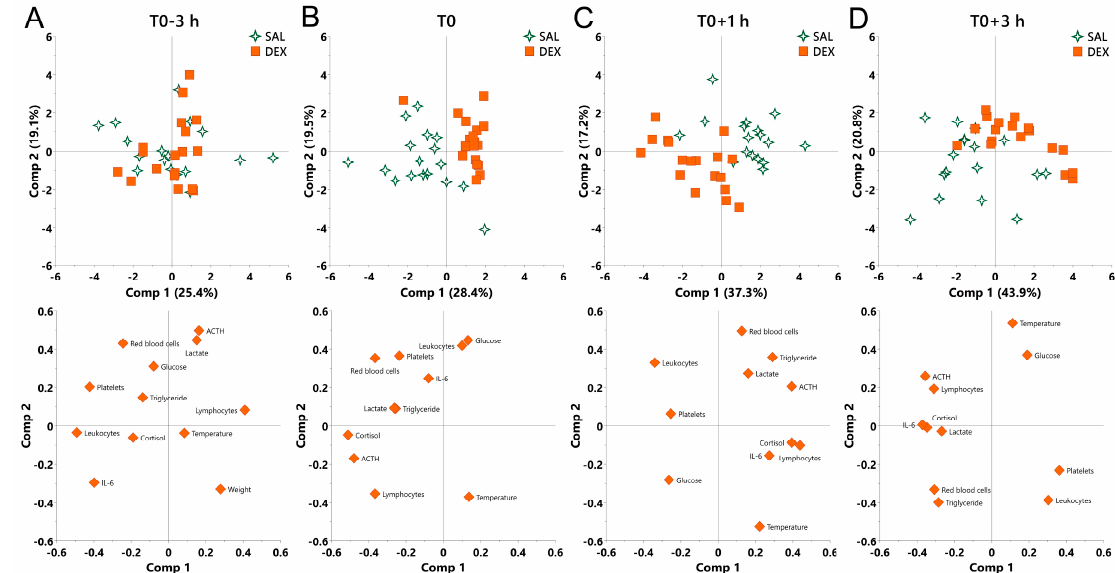
Figure 5. Principal component analysis (PCA) for the overall effect of DEX on pigs under normal and endotoxemic conditions. ( A ) T0-3 h, baseline; ( B ) T0, the effect of DEX under normal condition; ( C ) T0+1 h and ( D ) T0+3 h, the effect of DEX under endotoxemic condition. Loading of the parameters on component 1 and 2 are visualized below the PCA score plot to show the contribution of parameters to the group separation. SAL, saline; DEX, dexamethasone; Comp,